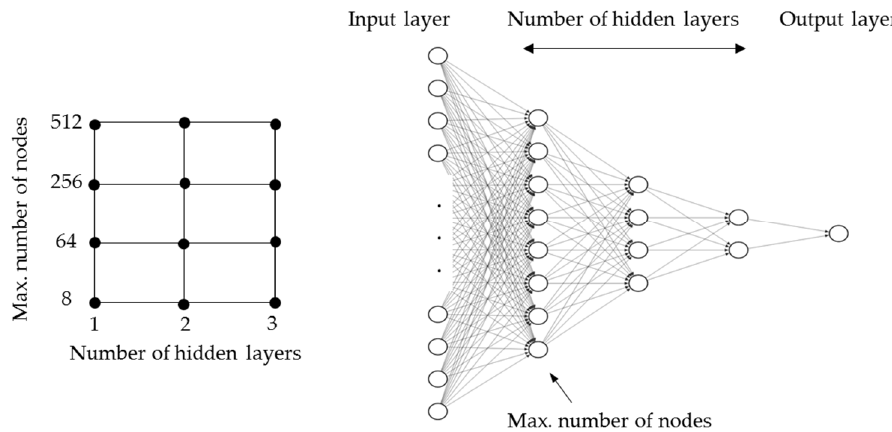
Figure 9. Applied scheme of grid search and corresponding model hyperparameters.